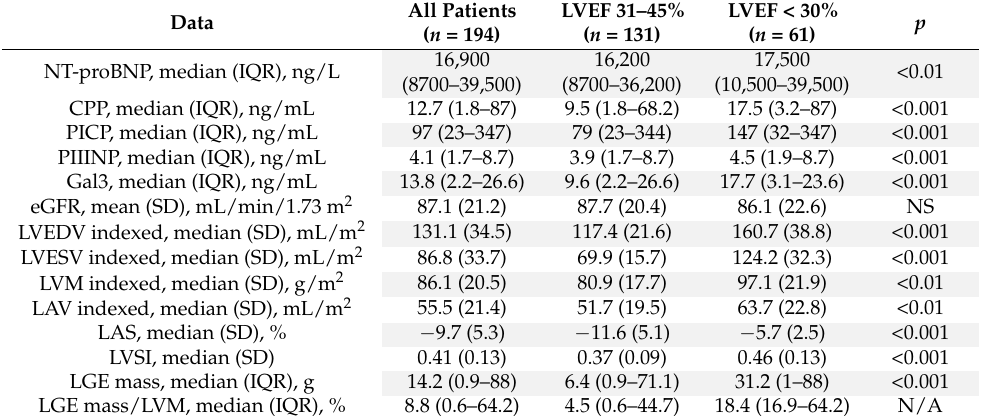
Table 2. Comparison between NIDCM patients with severely and non-severely decreased LVEF.